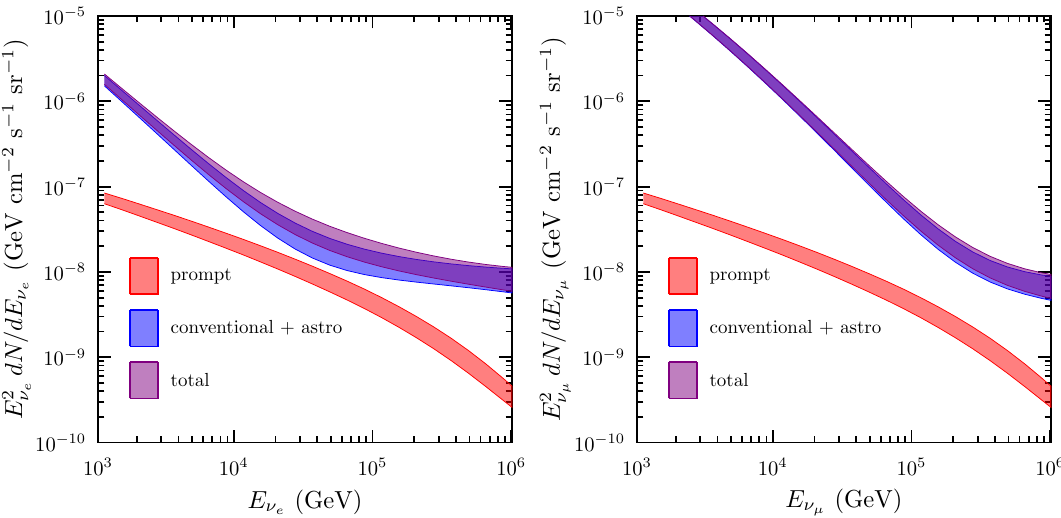
Figure 6. The expected electron (left panel) and muon neutrino (right) flux components in the energy range from 1 TeV to 1 PeV. Prompt neutrinos are shown separately and summed with all other components. From Reference